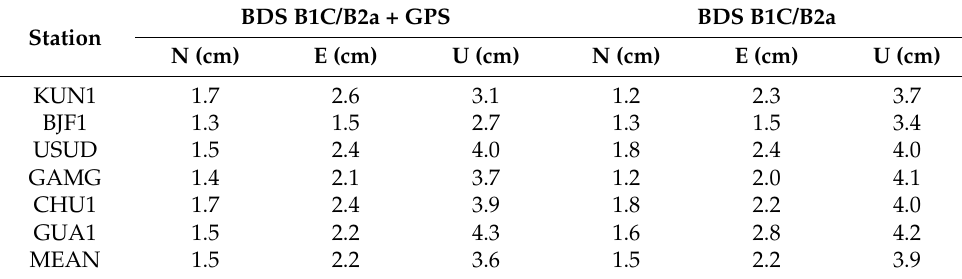
Table 7. Mean RMS values of PPP-B2b static positioning of each station using B1C/B2a.